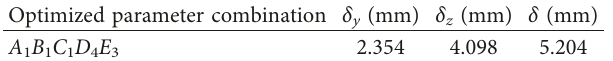
Figure 4: Relationship between experimental factors and springback index: (a) horizontal springback; (b) vertical springback; (c) total springback. Table 5: Springback value of the optimized parameter